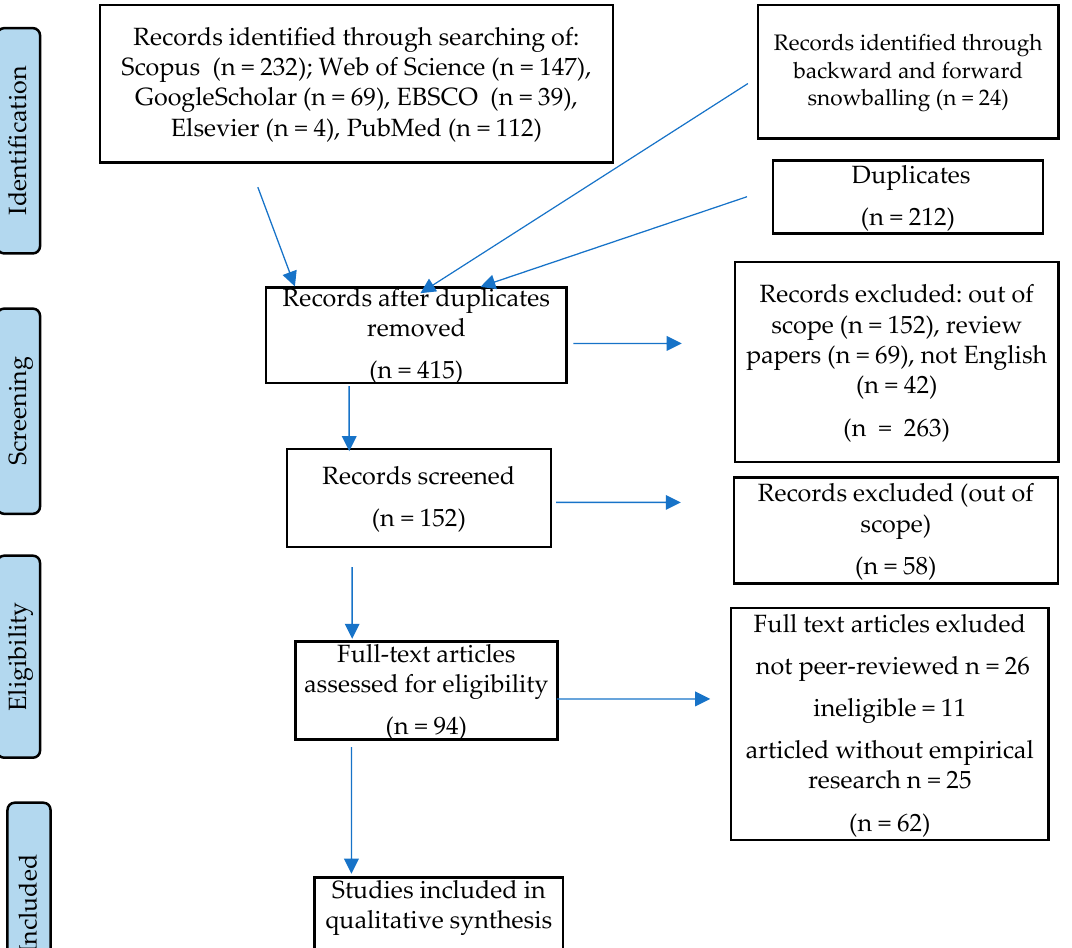
Figure 1. The procedure of identification, screening, eligibility assessment, and inclusion within the systematic review (PRISMA). Source: [82,83].